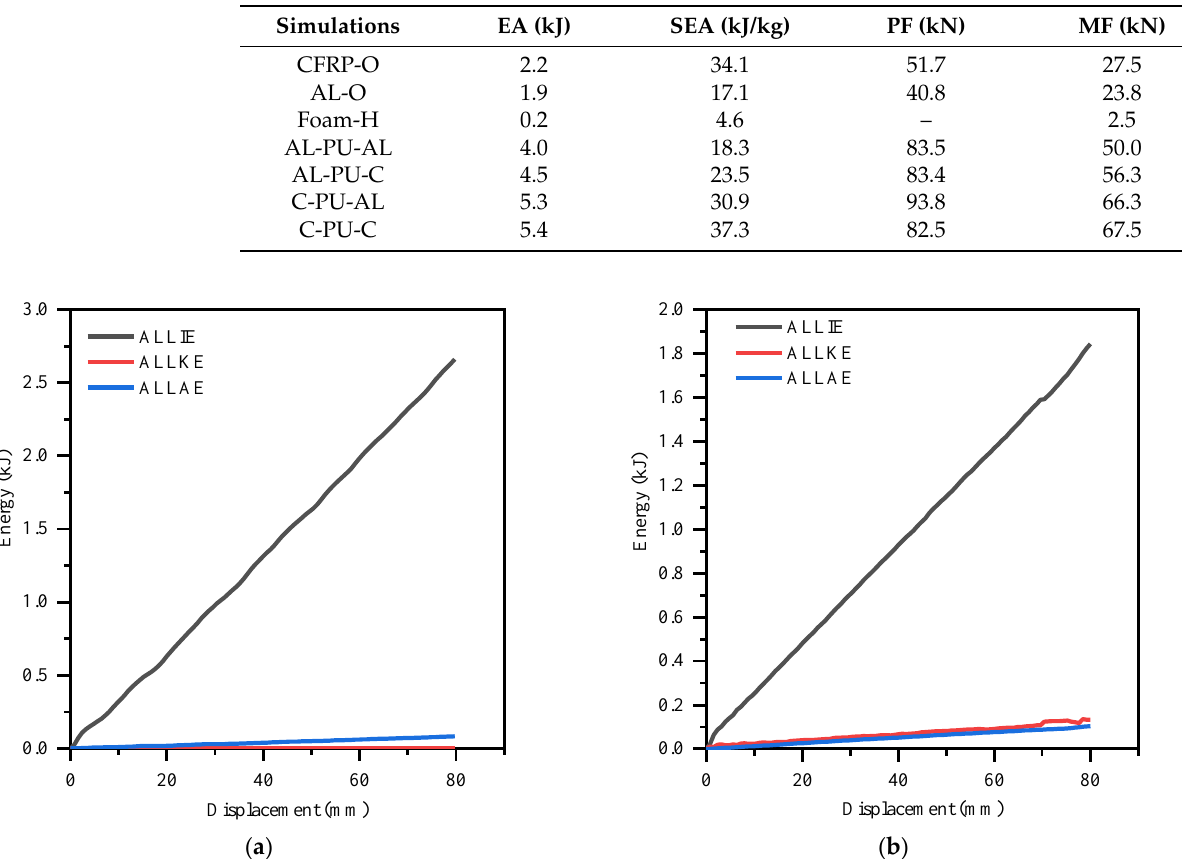
Figure 10. Comparison of force–displacement curves between the experimental results and simulation results: ( a ) AL-O; ( b ) C-O; ( c ) AL-PU-AL; ( d ) AL-PU-C; ( e ) C-PU-AL; ( f ) C-PU-C. Table 4. Summary of crashworthiness indicators of single tubes and hybrid structures obtained from the simulation results.